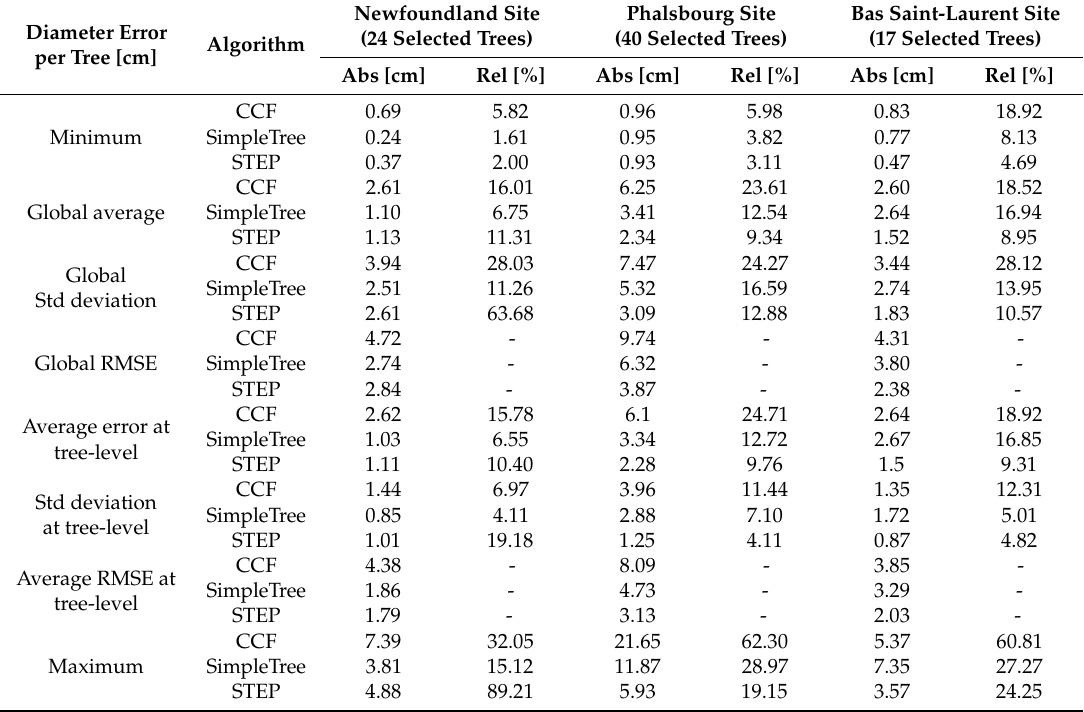
Table 3. Results of the stem diameter estimation with the three selected